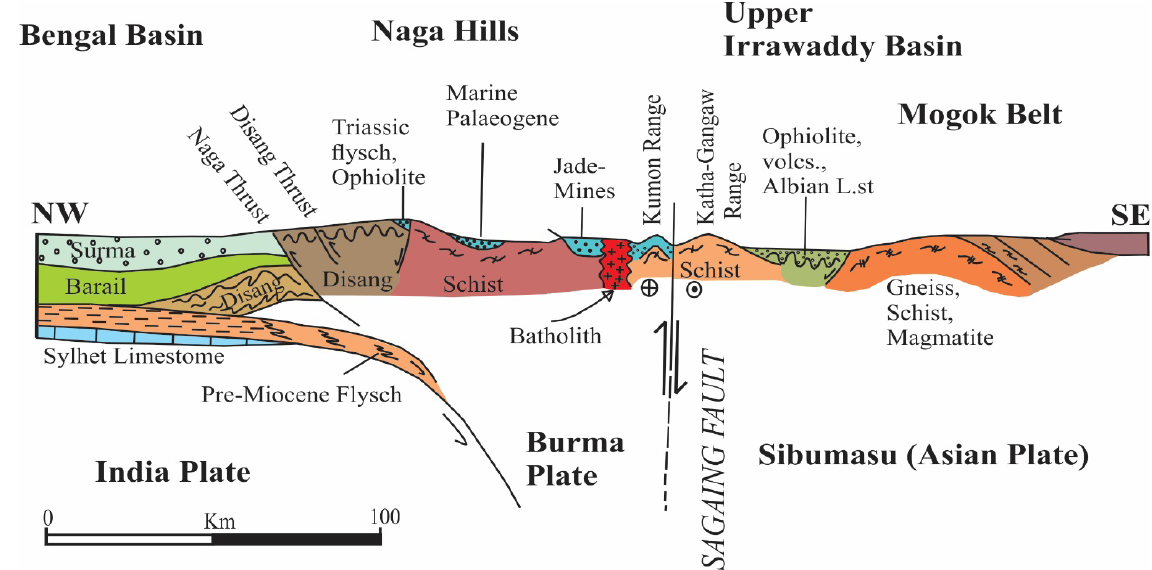
Figure 11. Northwest–southeast-oriented schematic cross section showing the northern Myanmar region during Mesozoic–Cenozoic time. The present-day suture boundary along the Sagaing fault zone along the western margin of the Katha-Gangaw range between western Myanmar and Sibumasu modified after Mitchell [36].